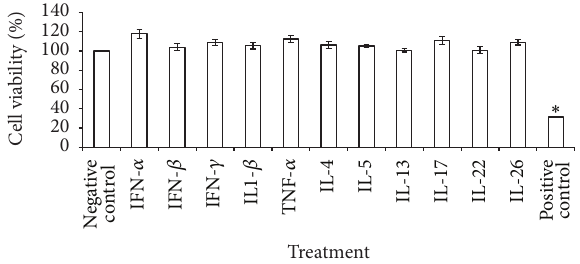
Figure 3: Th1, Th2, and Th17 cytokines and interferons do not have cytotoxic effects on HNECs. Relative viability as determined by the LDH assay after 24 h treatment of Th1, Th2, and Th17 on HNECs. Cell viability was calculated relative to the untreated cells (0 𝜇 g/mL) as negative control. The values are shown as means ± SEM, 𝑛 = 4